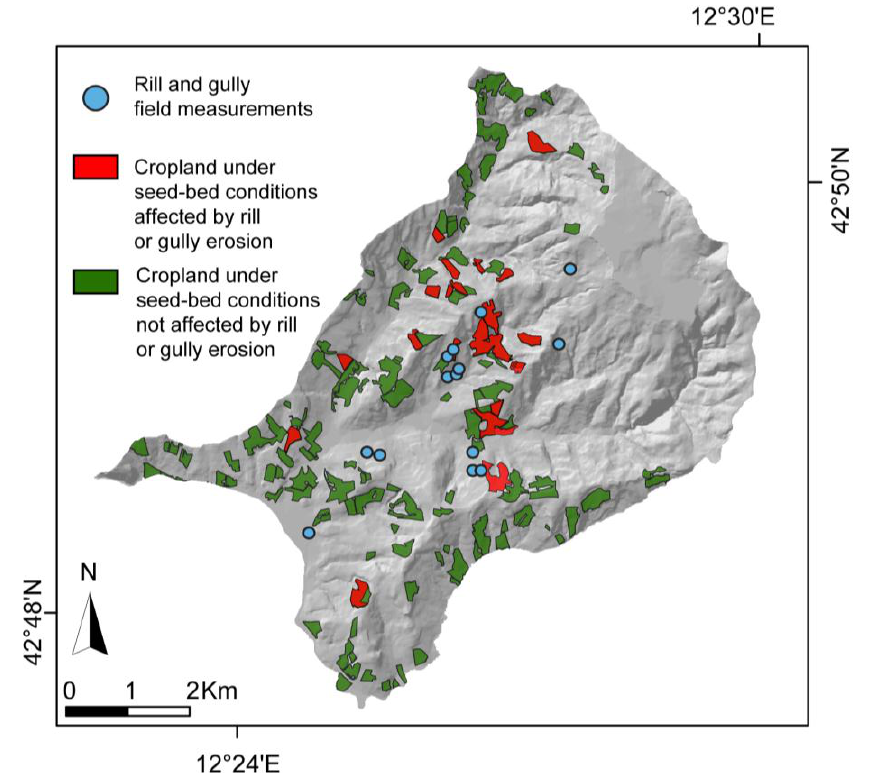
Figure 9. Map that shows the locations of the field measurements of the rills and gullies (blue dots), the cropland under seed-bed conditions that were affected by channeled erosion (red polygons), and the cropland under seed-bed conditions not affected by rill and gully erosion (green